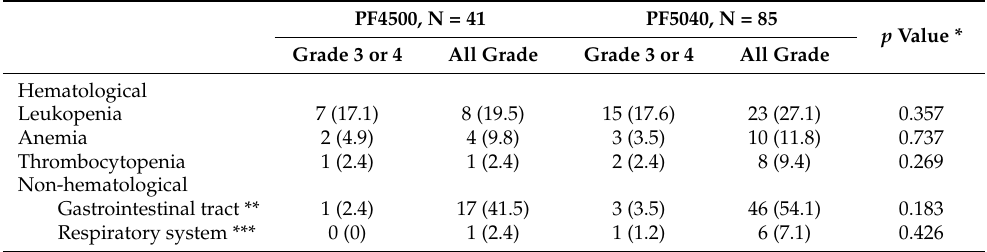
Table 6. Adverse events of neoadjuvant chemoradiotherapy of patients in PF4500 and PF5040